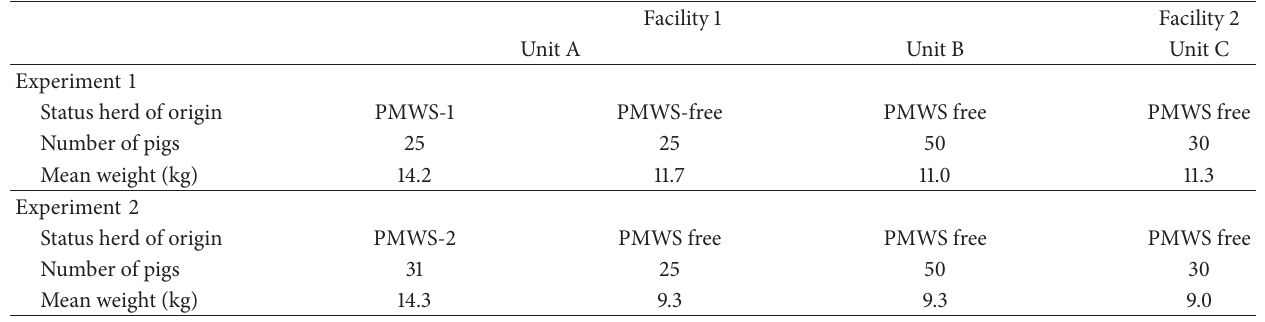
Table 1: Distribution of pigs in the two